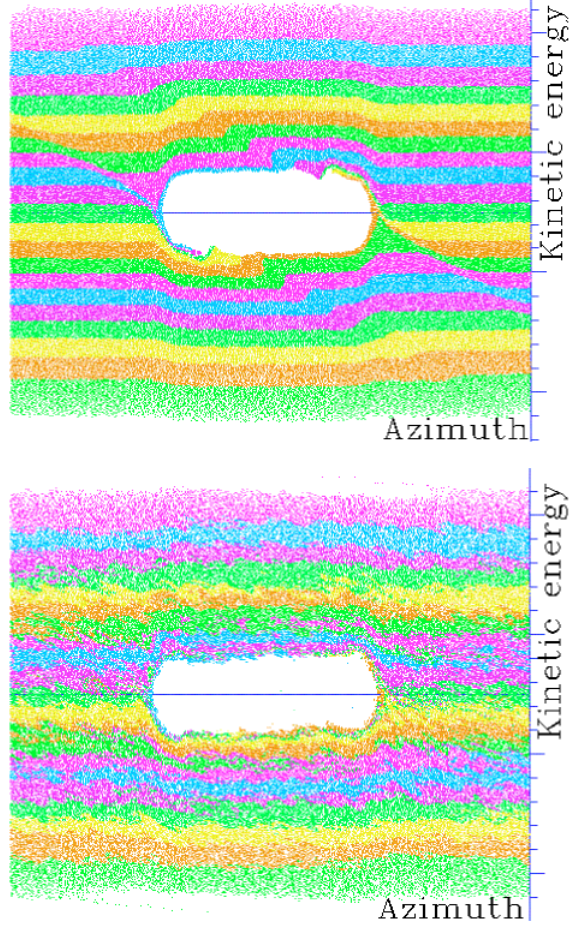
FIG. 21. (Color) Phase space scatter plots at 2 14.74 ms (top) and 2 12.49 ms (bottom), 5 3 10 12 protons.